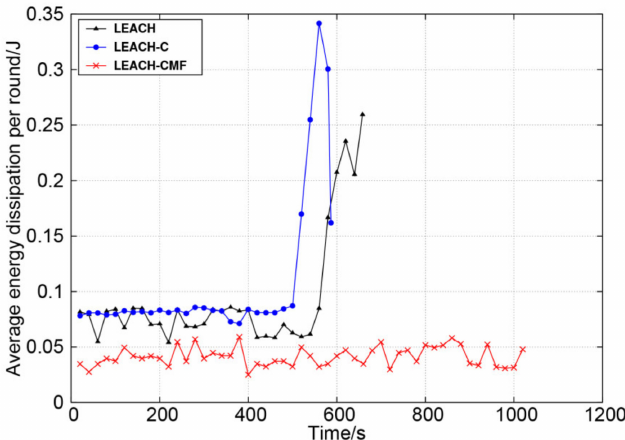
Figure 11. The average node energy dissipation of each round.